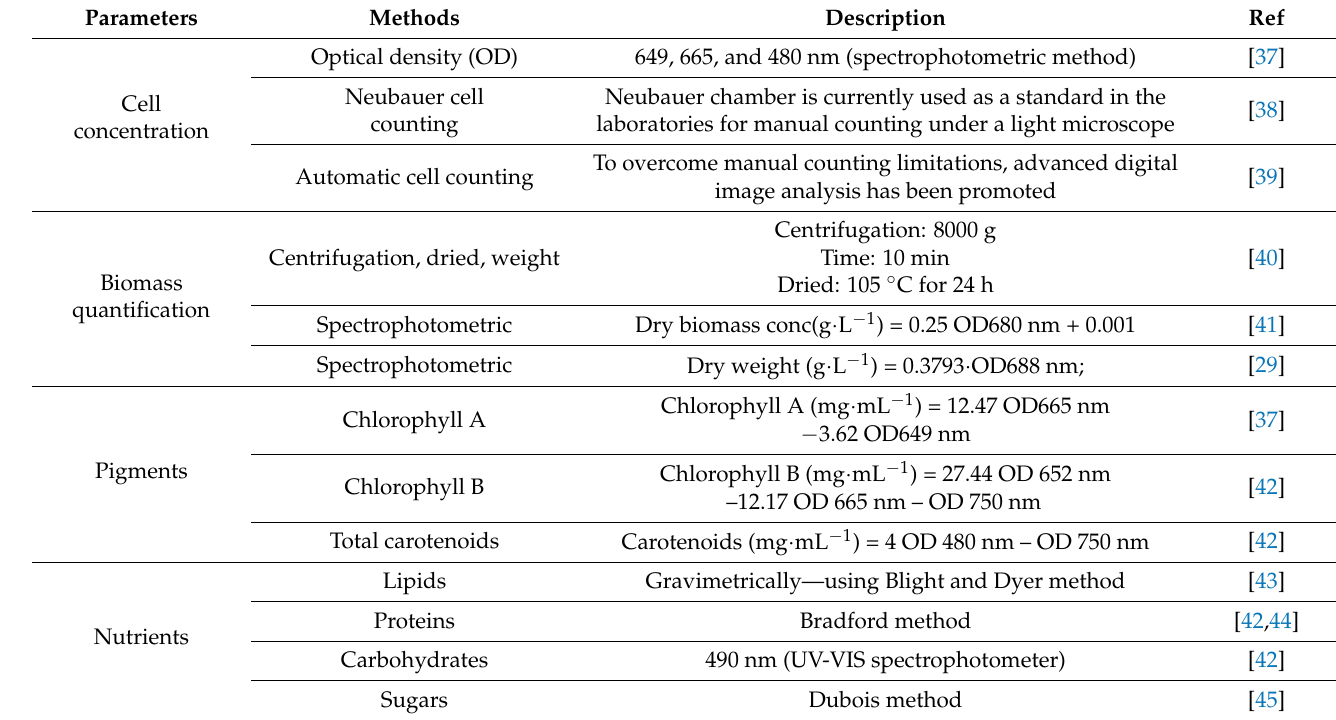
Table 2. Parameters and methods for determining the development of Chlorella vulgaris .